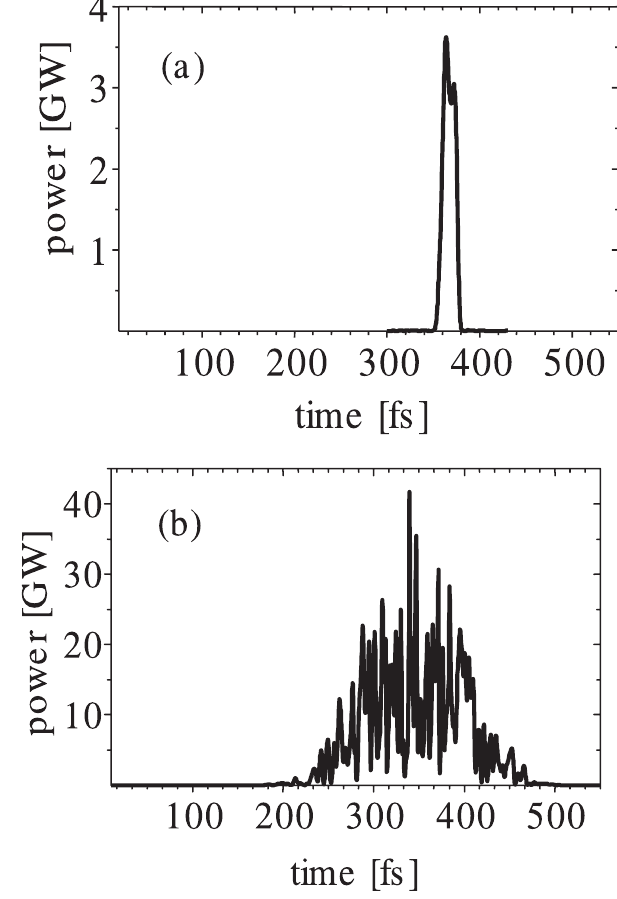
FIG. 8. (a) Typical time structure of an HGHG-FEL. (b) Typical time structure of a SASE-FEL.